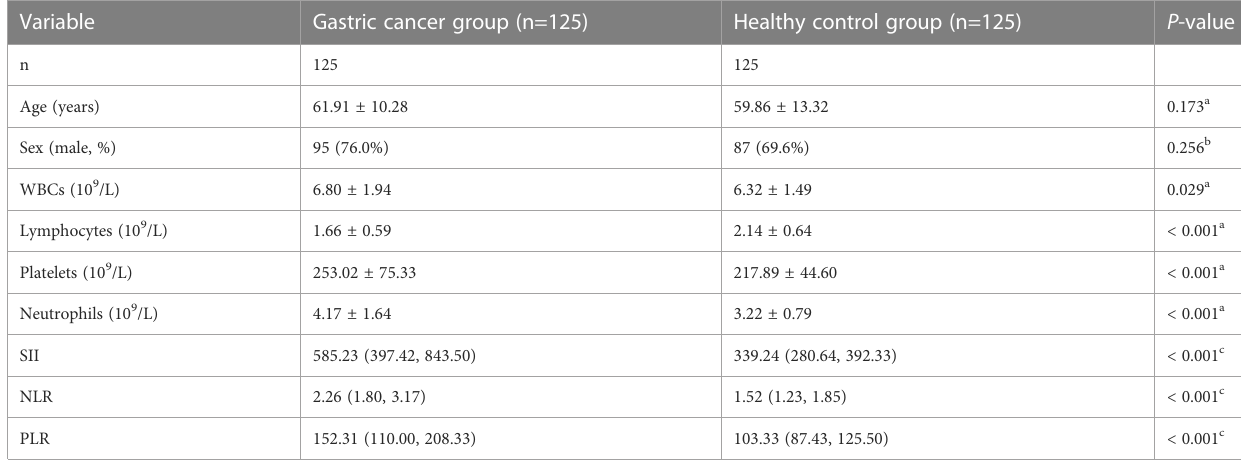
TABLE 1 Laboratory values of gastric cancer patients and healthy